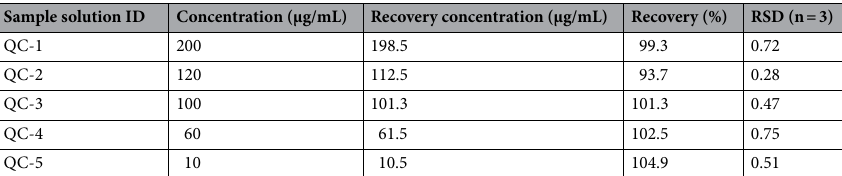
Table 6. Accuracy and of recovery of the cuprizone method.